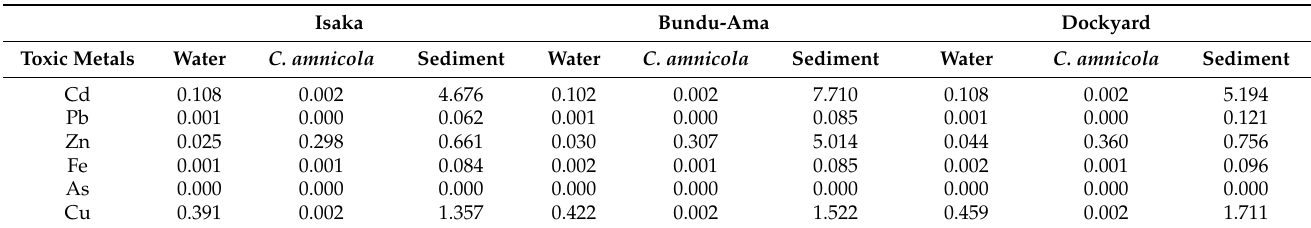
Table 5. Toxic metal geo-accumulation index (Igeo) and pollution load index (PLI) in the Isaka–Bundu tidal mangrove swamp.